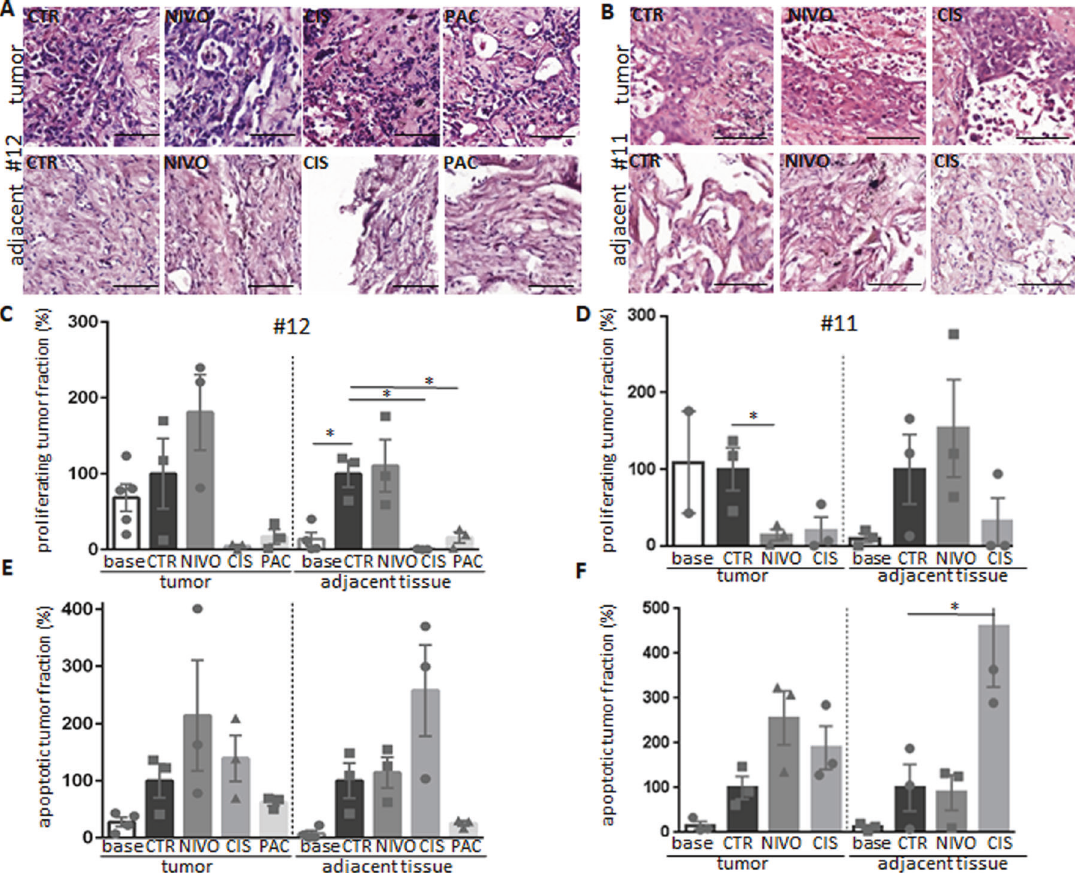
Fig. 3 Individual susceptibility in squamous cell carcinoma of the lung and in adjacent tissue. Tissue specimens were treated for 5 days with nivolumab (3 µg/ml), cisplatin (10 µM), or paclitaxel (100 nM, only #12), depending on tissue availability. Shown are representative outcome from patient #12 that did not respond to nivolumab ex vivo (left) and patient #11 that responded (right). Representative HE sections of the tumor as well as of the adjacent tissue of #12 ( A ) and #11 ( B ) at 6 days in culture are shown. Bar = 100 µm. Tumor tissue and adjacent healthy epithelial tissue were evaluated for proliferation ( C, D ) as well as for apoptosis ( E, F ). The adjacent tissue of #12 was not free of tumor cells but only tumor-free areas were evaluated. * p < 0.005 in one-way Anova tested against the control condition. Base